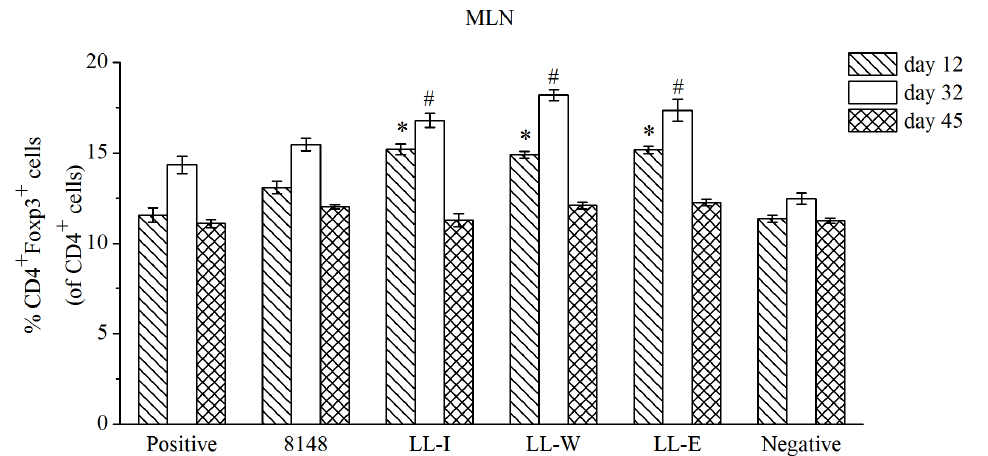
Figure 6. Effect of the recombinant L.lactis treatment on the proportion of CD4 + Foxp3 + T cells in the MLN. On days 12, 32 and 45, the levels of CD4 + Foxp3 + T cells in the MLN from the respective groups were analyzed by FACS. Results were reported as means 6 SEM. * P , 0.05 vs the positive group (day 12). # P , 0.05 vs the positive group (day 32).